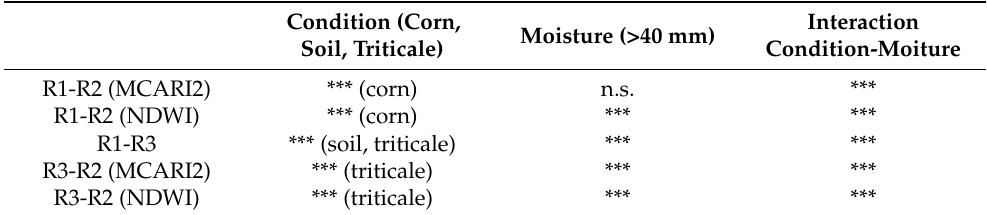
Table 2. Significance of the soil condition and soil moisture in relation to the correlations between the survey methods. Condition (Corn, Interaction Moisture (>40 mm) Soil, Triticale) Condition-Moiture R1-R2 (MCARI2) *** (corn) n.s. *** R1-R2 (NDWI) *** (corn) *** *** R1-R3 *** (soil, triticale) ***